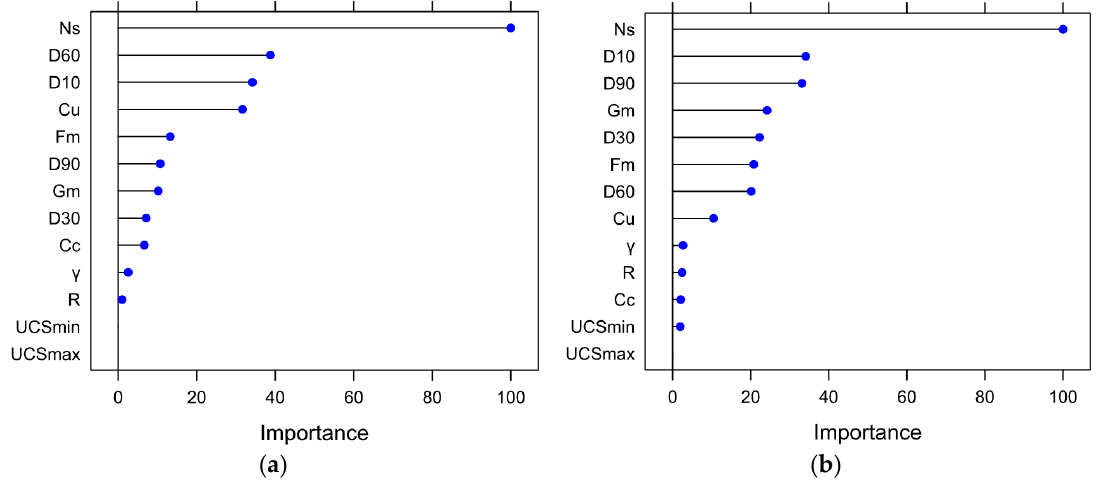
Figure 7. Variable importance scores for the 13 predictors in the proposed models for shear strength of RFM: ( a ) Cubist model, and ( b ) random forests model.